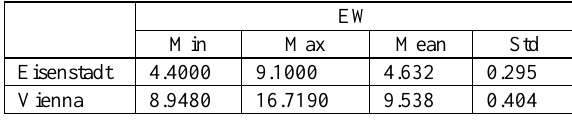
Table 4. The EW thresholds for Eisenstadt and Vienna